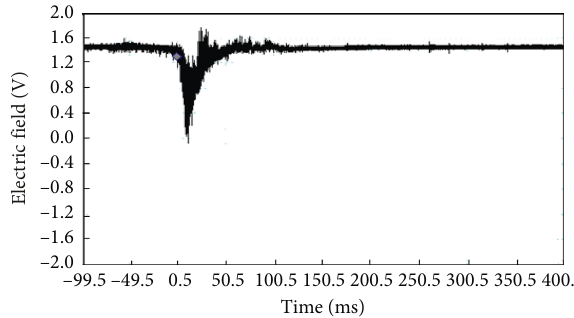
Figure 7: An example of the electric field of a cloud flash that apparently consists of a single